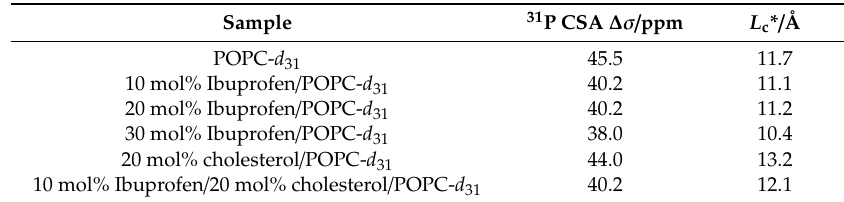
Table 1. Chemical shift anisotropy (CSA) ∆ σ in the 31 P-NMR spectra and calculated chain